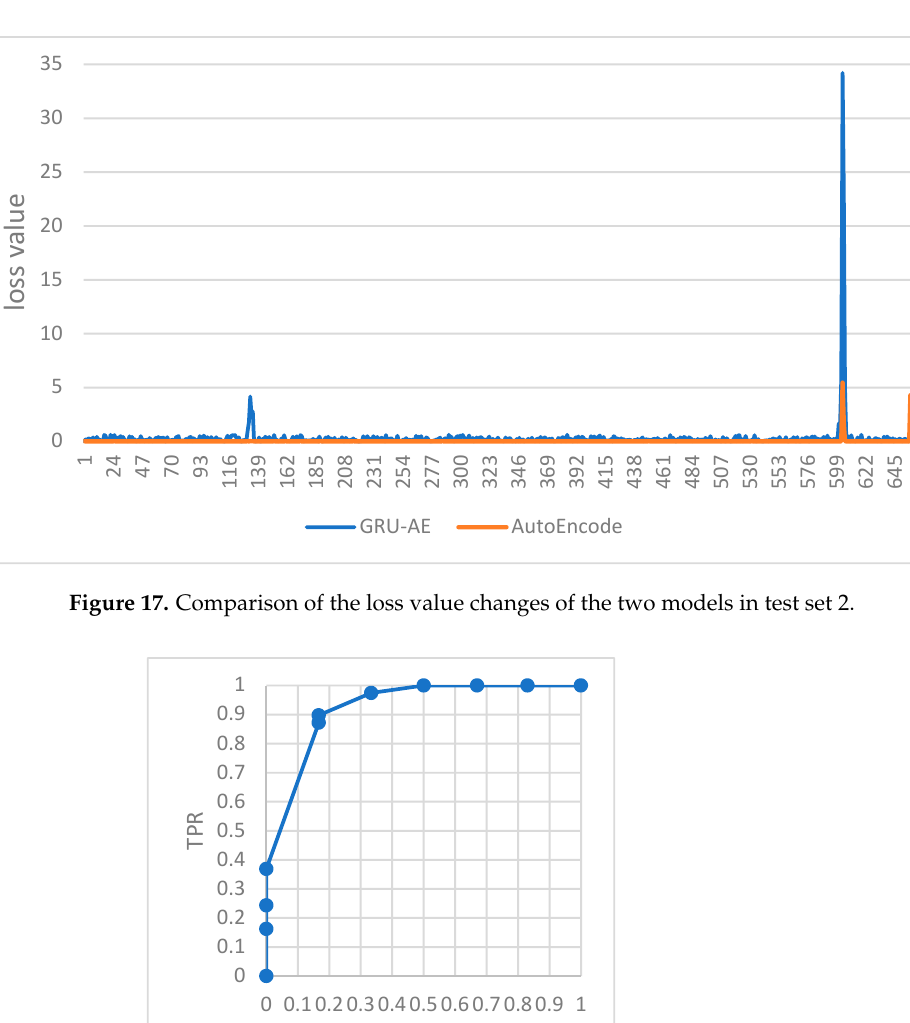
Figure 16. Comparison of the loss value changes of the two models in test set 1.